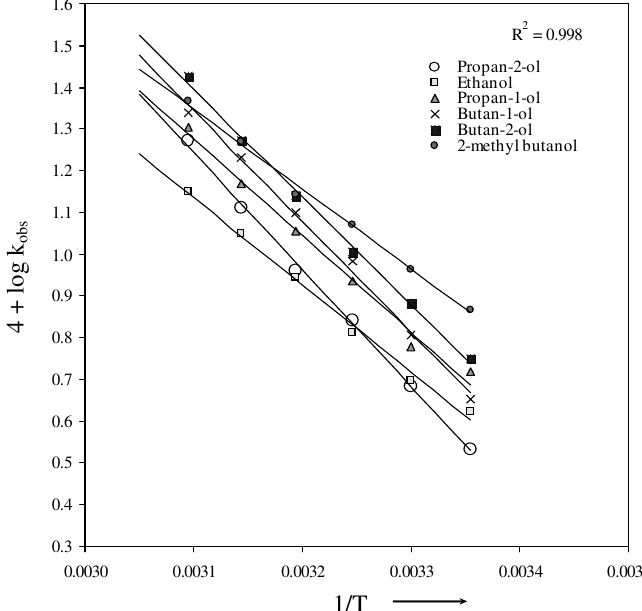
Figure 4. Variation of rate with